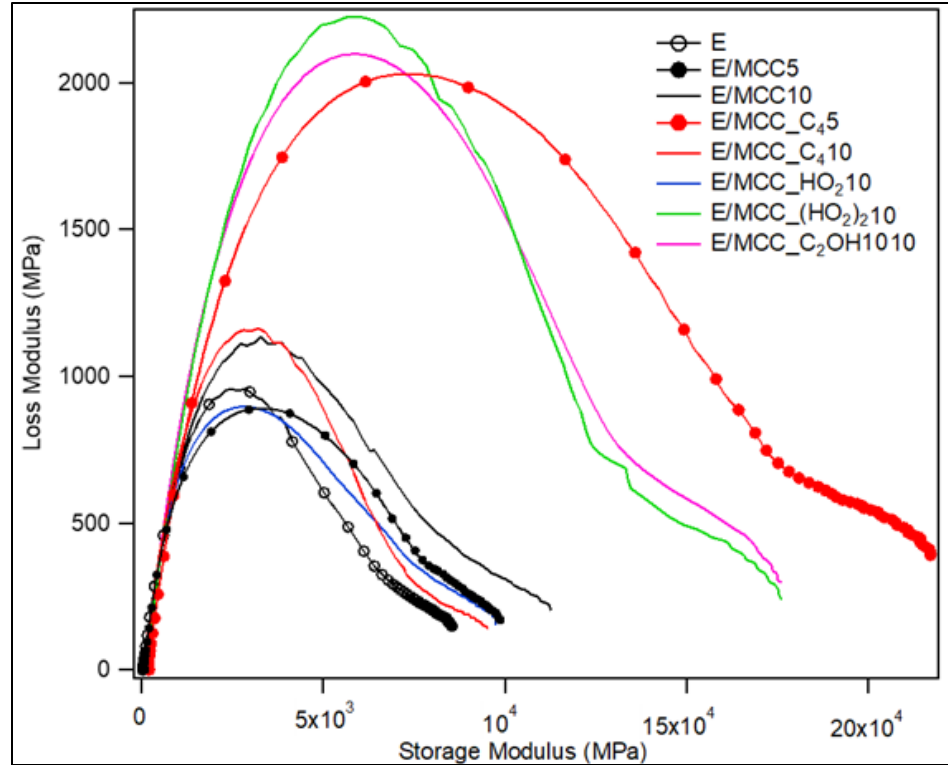
Figure 10. Cole-Cole curves for epoxy and the MCC/epoxy composites.